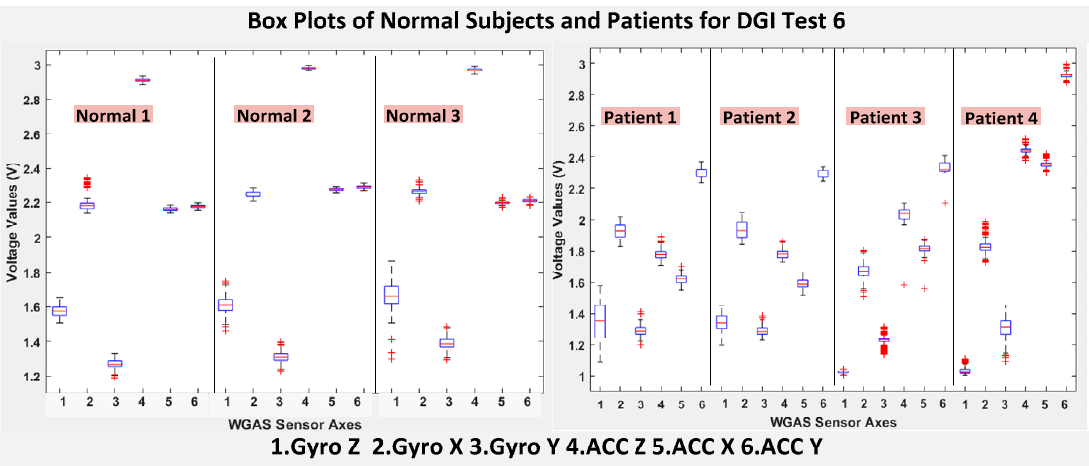
Figure 7. Box plots of DGI Test 6: Data for normal subjects (left) vs. patients (right).